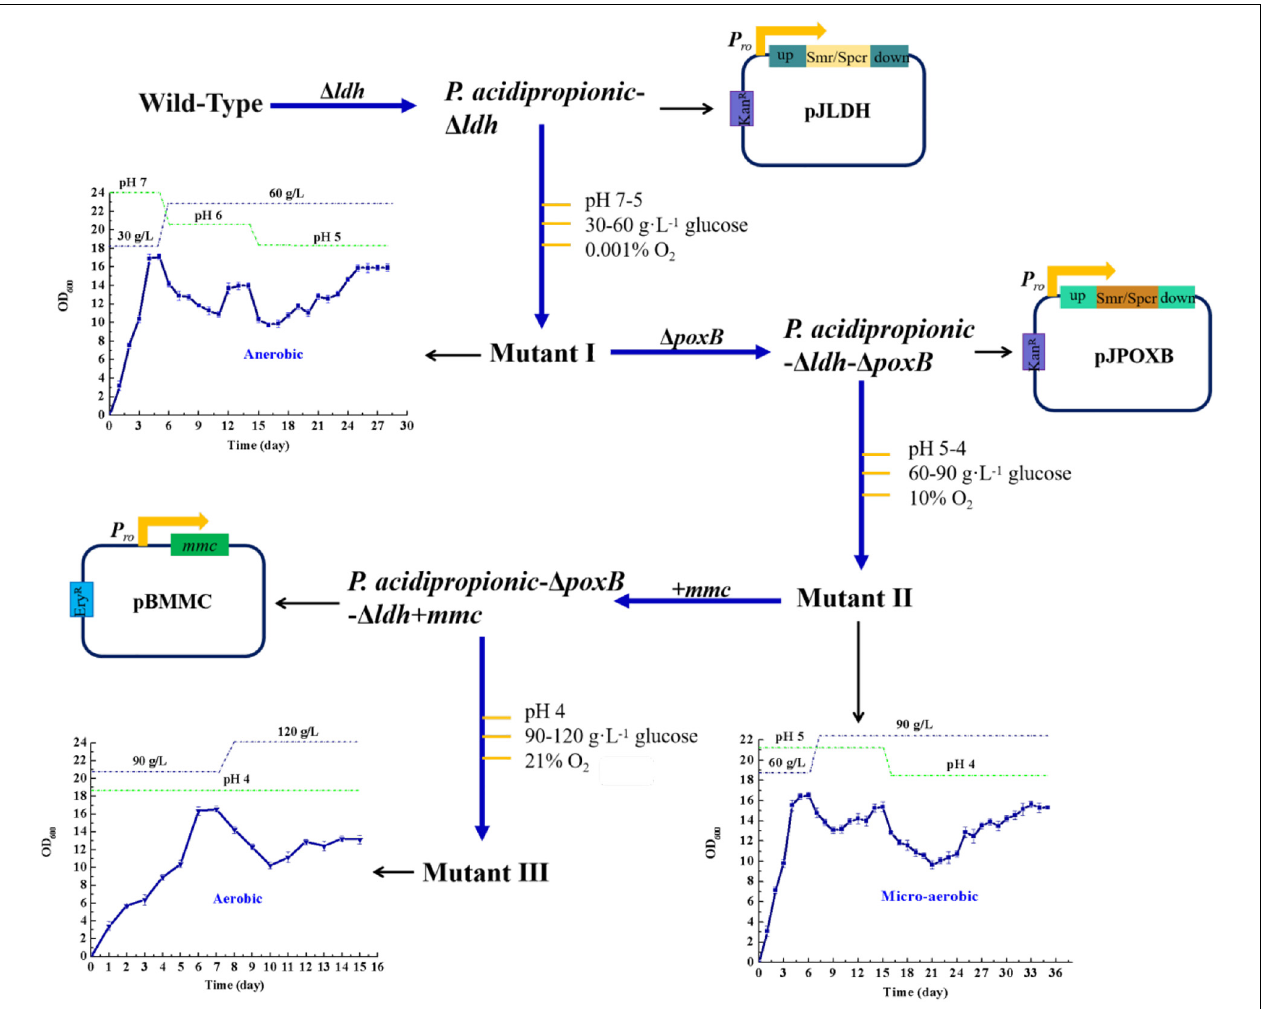
FIGURE 1 | A schematic overview of the experimental setting in regard to metabolic and evolutionary engineering of P. acidipropionici